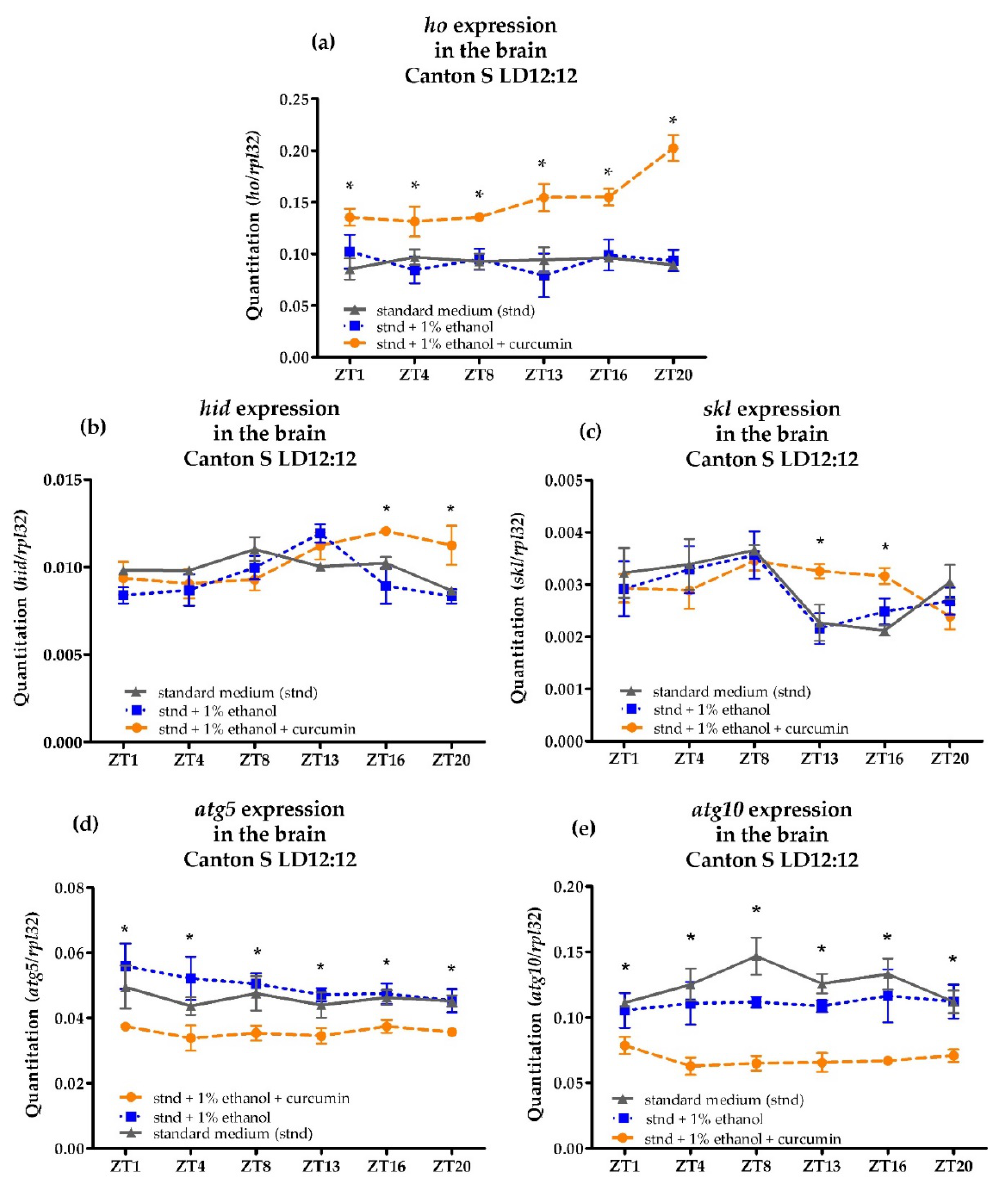
Figure 4. Effects of chronic curcumin supplementation on the mRNA level of heme oxygenase ( ho ) ( a ), apoptosis activator head involution defect ( hid ) ( b ) and sickle ( skl ) ( c ), and autophagy-related 5 ( atg5 —( d ) and atg10 —( e ) genes in the brain of adult males of Drosophila melanogaster . Data shown as means ± SD. Statistically significant differences between groups are indicated with asterisks ( p <